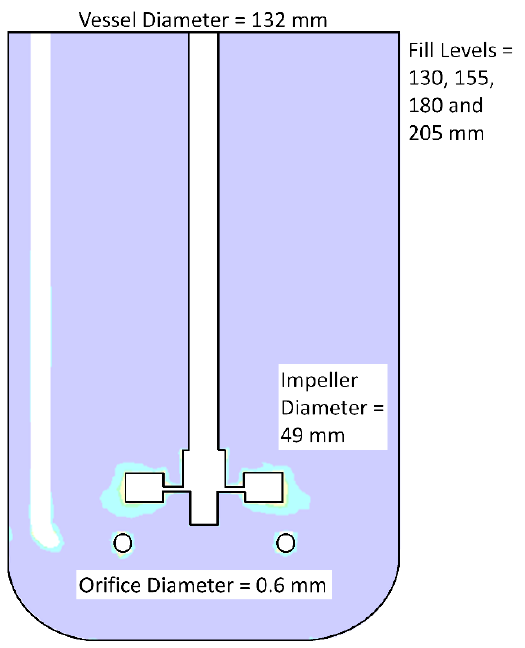
Figure 3. Geometry of the vessel considered for the CFD simulations. Table 1. Physical properties calculated from CFD simulations.